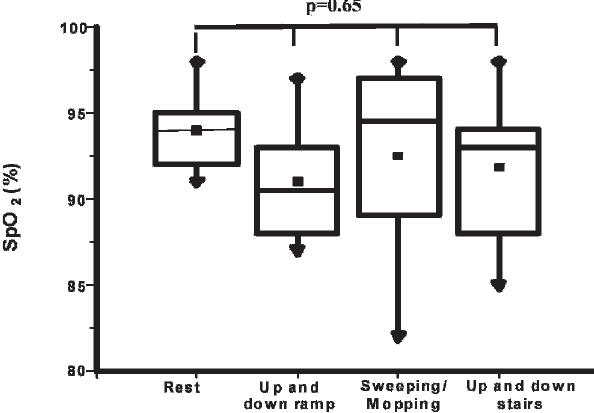
Figure 4 - Boxplot of resting and post-activity (walking up and down a ramp, sweeping/mopping and walking up and down